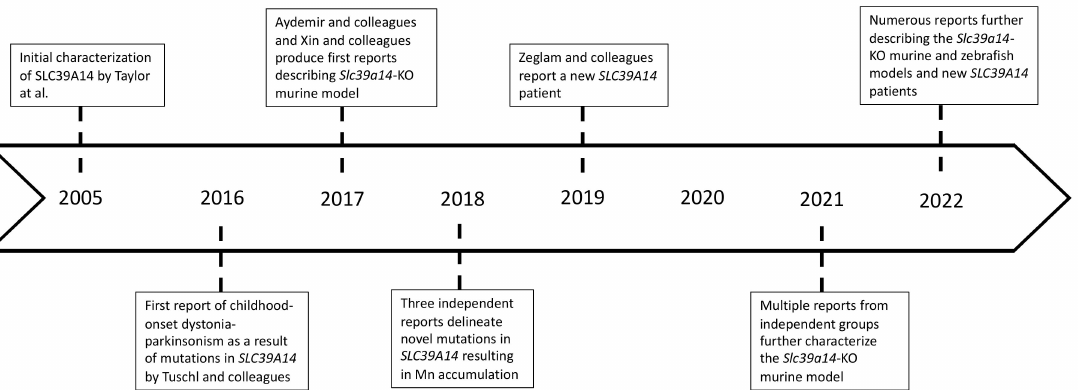
Figure 2. Timeline of significant discoveries related to SLC39A14 human cases and disease